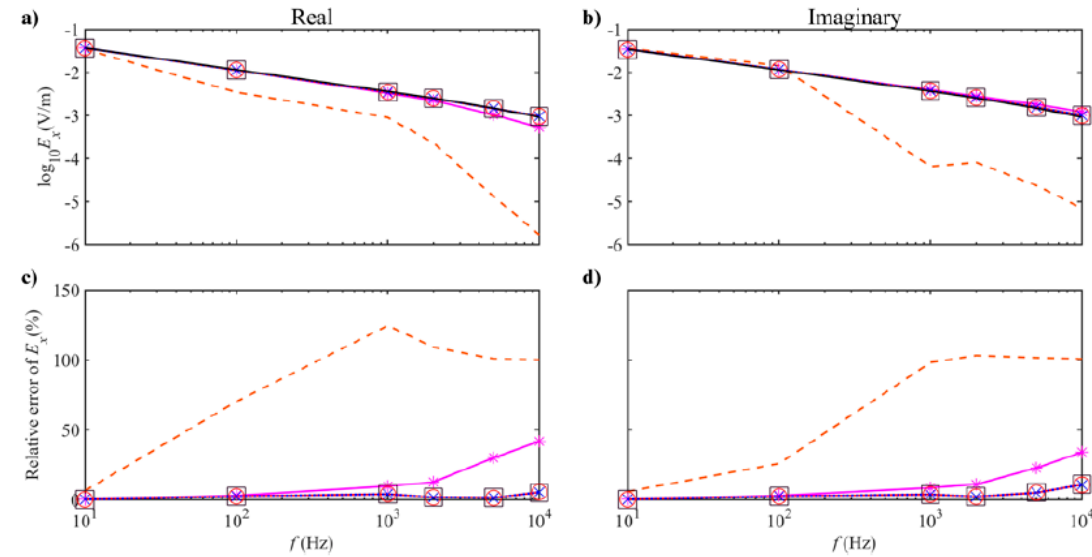
Figure 3. Comparison of the E x solutions from cases based on the quasi-static approximation with 10 − 4 (orange dashed lines), 10 − 6 (purple asterisk lines), 10 − 8 (dark green square lines), and 10 − 10 S / m (red circle lines) for air conductivity, and the one with the complete wavenumber (blue dotted cross lines) along with the analytical solution (solid lines) for model II. ( a ) the real part and ( b )the imaginary part of E x are indicated and the relative errors of ( c ) the real part of and ( d ) the imaginary part of E x are indicated.